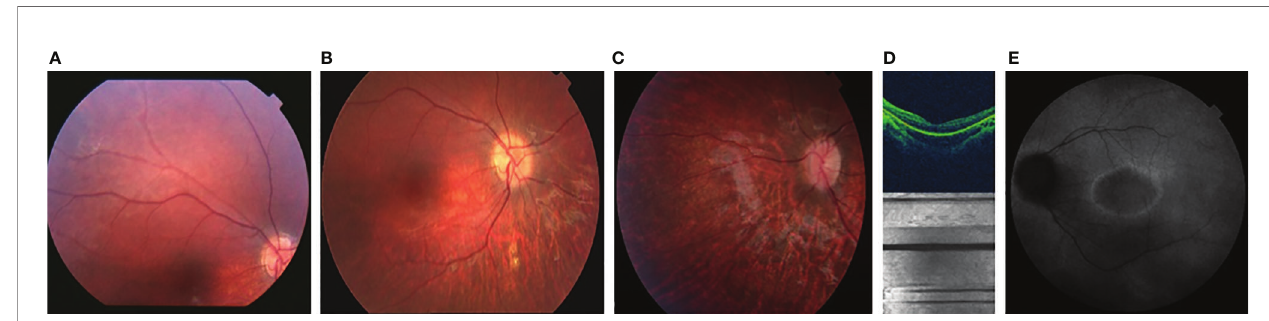
FIGURE 2 | Color fundus photographs [ (A) at the age of 2 yrs.], [ (B) at the age of 6 yrs. [ (C) at the age of 7 yrs.] showing the progression of the optic disc pallor with retinal arteriolar narrowing and pigment mottling; OCT image [ (D) at the age of 7 years, showing thinner retina predominantly the outer retinal layer with irregularities] AF [ (E) at the age of 10 years, showing hyper- fl uorescent ring around the macula with irregular fl uorescence of the